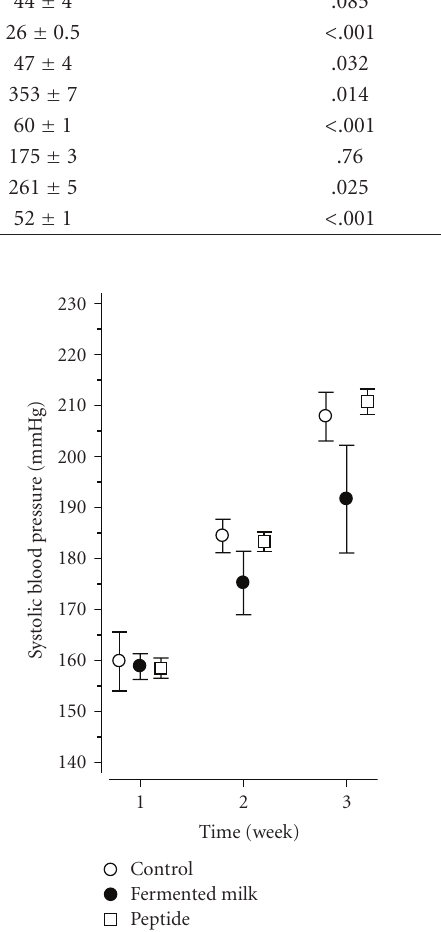
Figure 1: The mean ( ± SE) systolic blood pressure in di ff erent treatment groups. The number of animals in the beginning of the experiment: control 15, fermented milk and peptide groups 10/group. Week 3: 9, 6 and 8, respectively, ( P = . 023 between the